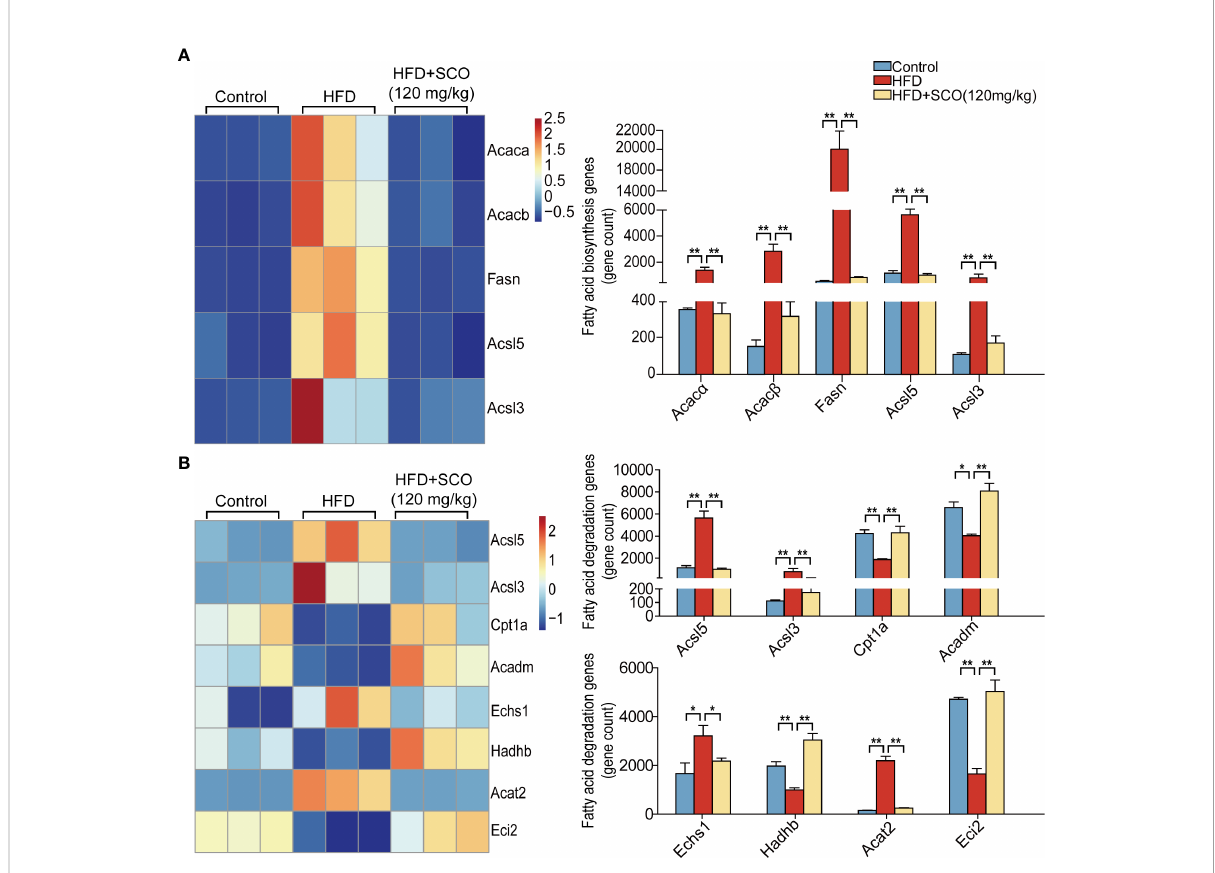
FIGURE 6 The differentially expressed genes of fatty acid metabolism in liver tissue. (A) Fatty acid synthesis genes. (B) Fatty acid (triglyceride) degradation genes. *Fold change ≥ 1.5 and P < 0.05. ** Fold change = 1.5 and P <